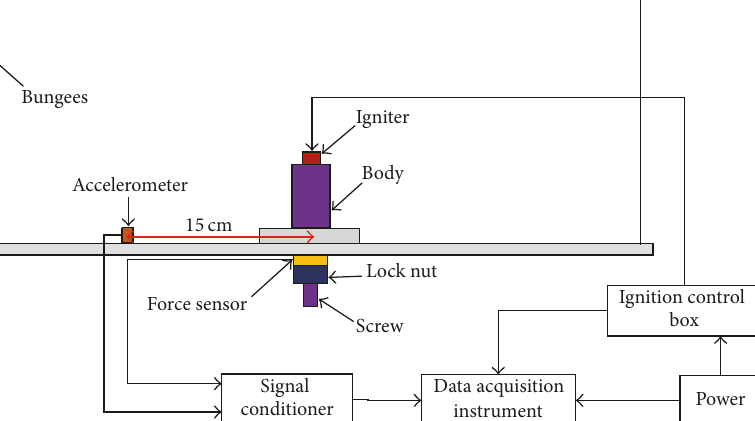
Figure 4: Schematic diagram of output shock measurement test platform installation structure for explosive bolts.